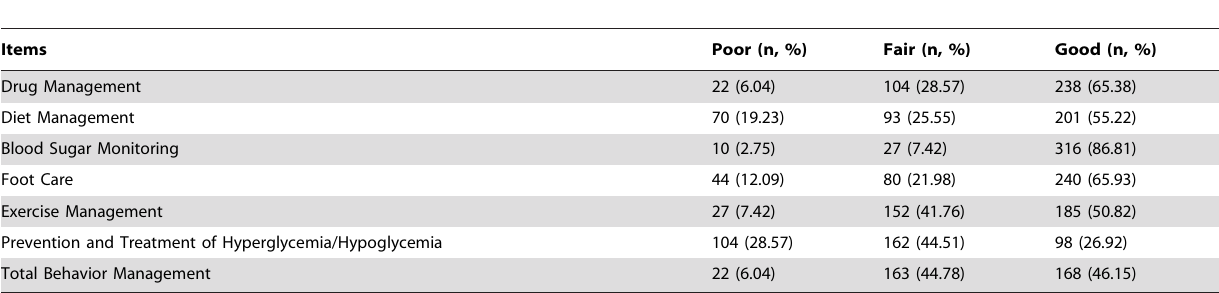
Table 2. Grade of T2DM self-management behavior for each dimension (N =364) g .